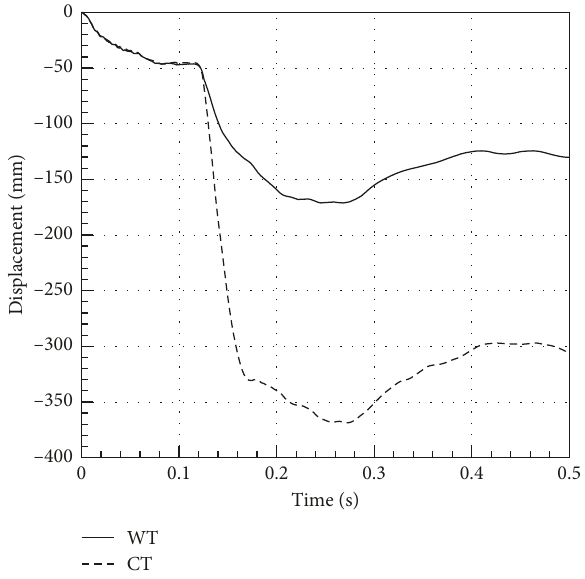
Figure 15: Displacement of the containment in the impact region with different fuel distribution.